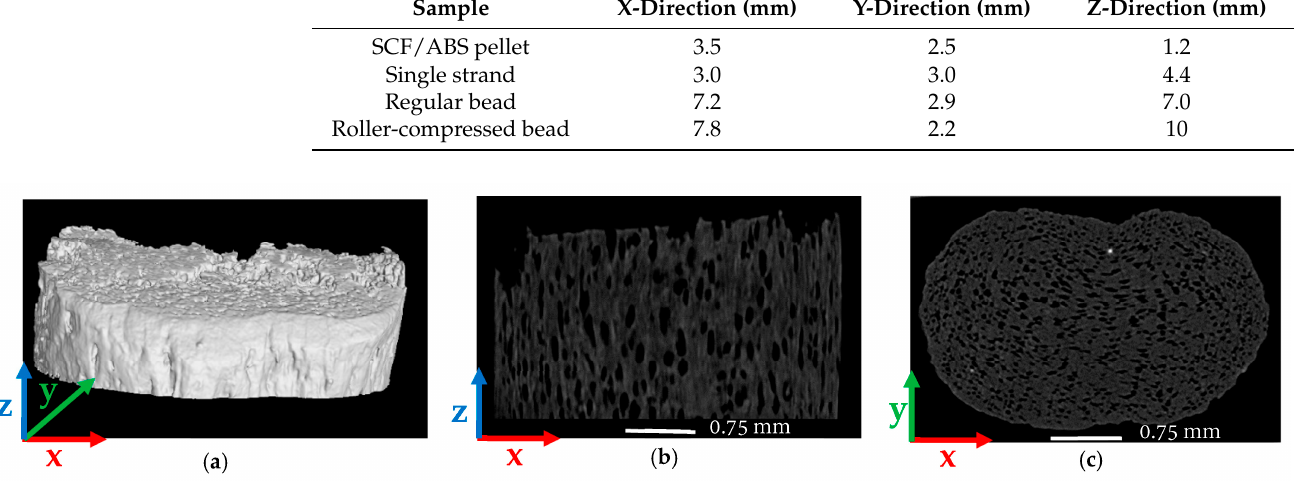
Figure 2. µCT images of SCF/ABS pellet: ( a ) 3D view; ( b ) 2D front view; ( c ) 2D top view. Figure 2. µ CT images of SCF/ABS pellet: ( a ) 3D view; ( b ) 2D front view; ( c ) 2D top